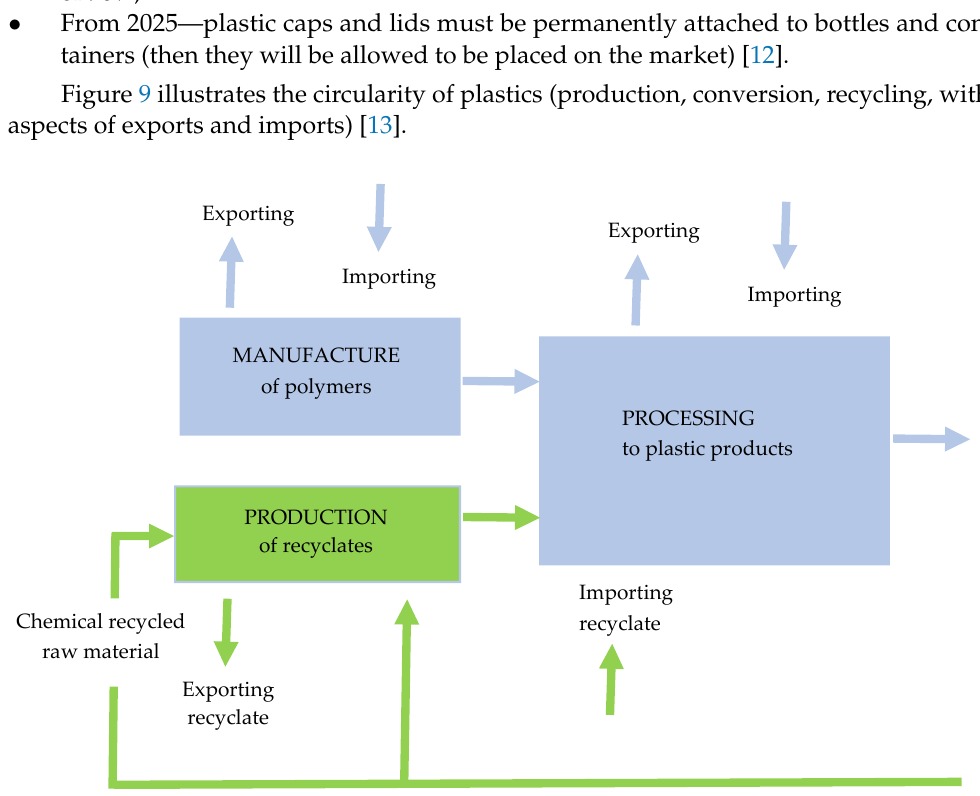
Figure 9. The circularity of plastics. Made based on [13].